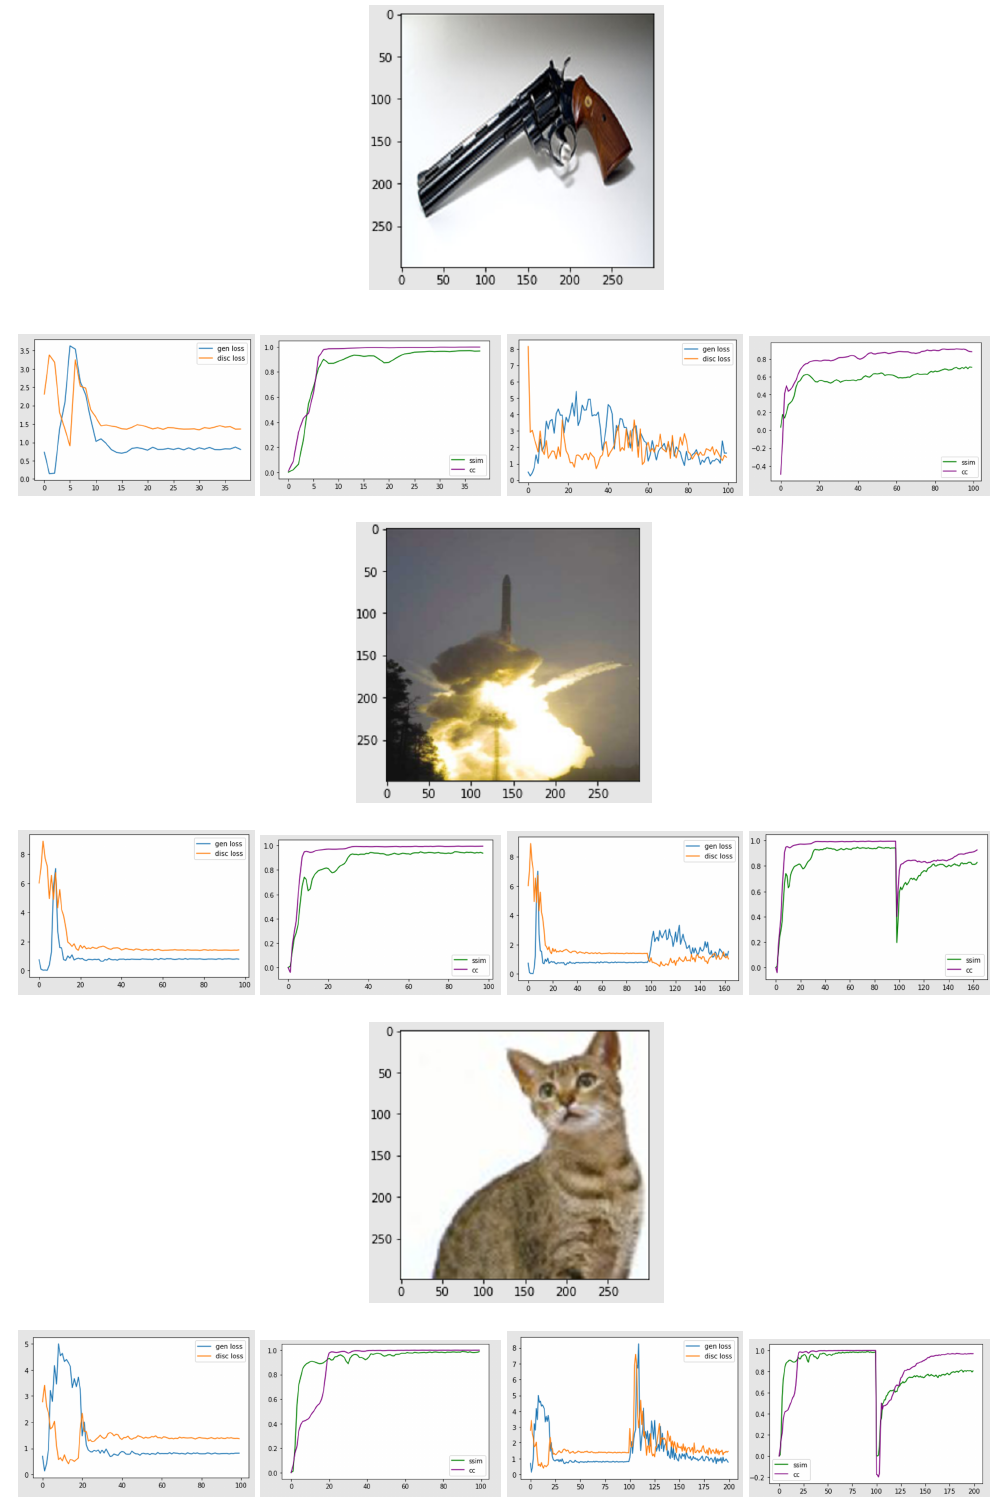
Figure 15. Training loss and accuracy plots; from left to right: Image used as stimulation, gener- ator, and discriminator loss for image saliency reconstruction, SSIM, and CC for image saliency reconstruction, generator, and discriminator loss for image reconstruction, SSIM, and CC for image reconstruction for three categories, including 8, 21, and